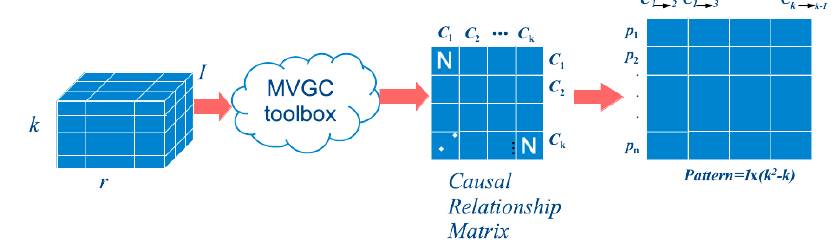
Figure 6. Causal relationships matrix generation Λ I using CWG